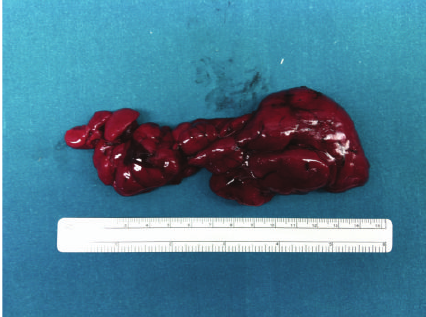
Figure 1: Adult rhabdomyoma (the large tumor was red lobulated mass).